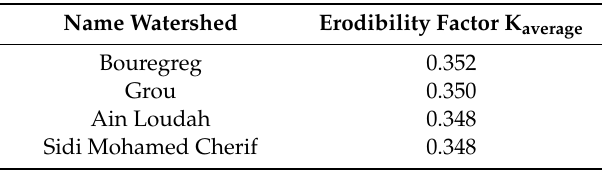
Table 8. Average erodibility factor for each